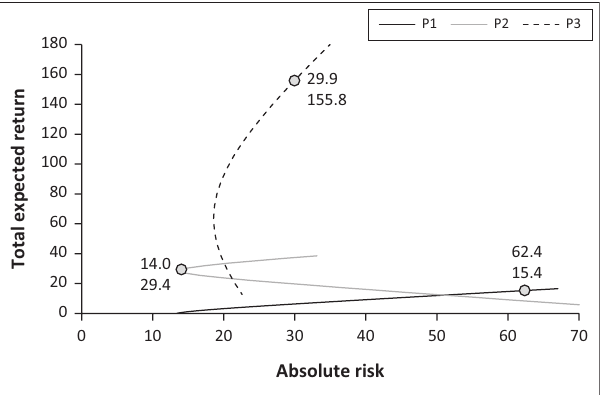
FIGURE 5: Portfolio B (base metals) efficient frontiers during periods 1, 2 and 3.